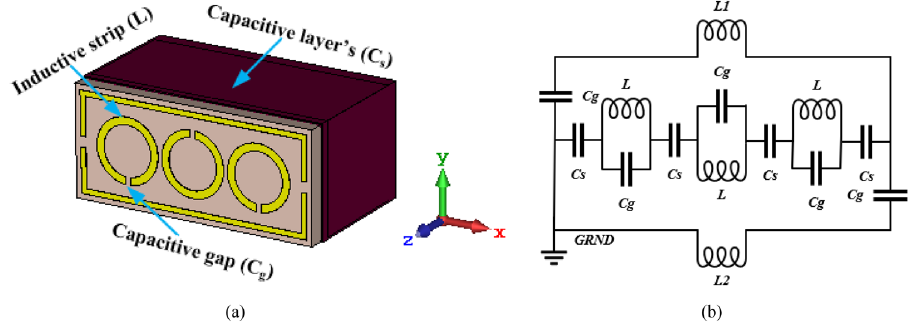
Figure 7. ( a ) Designed structure’s capacitive and inductive segments, ( b ) equivalent circuit of MTM sensor.